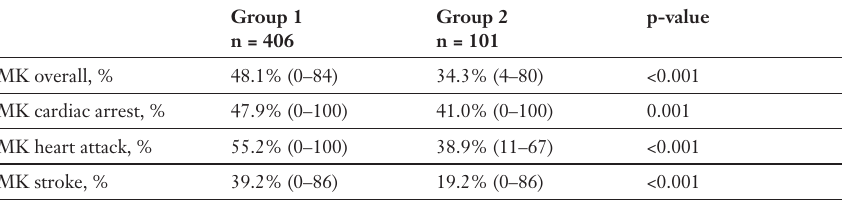
Table 2 Participants’ minimal knowledge in Basic Life